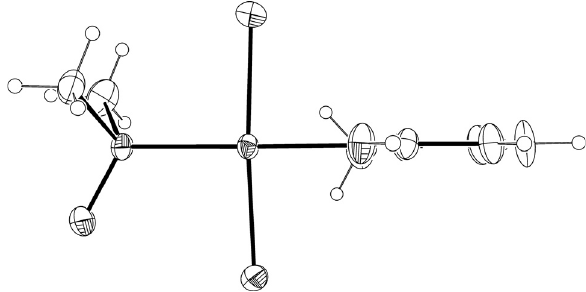
Fig. 2. Another drawing of the title complex emphasizing an almost perpendicular orientation of the Hmhp ligand relative to the plati- num coordination plane.